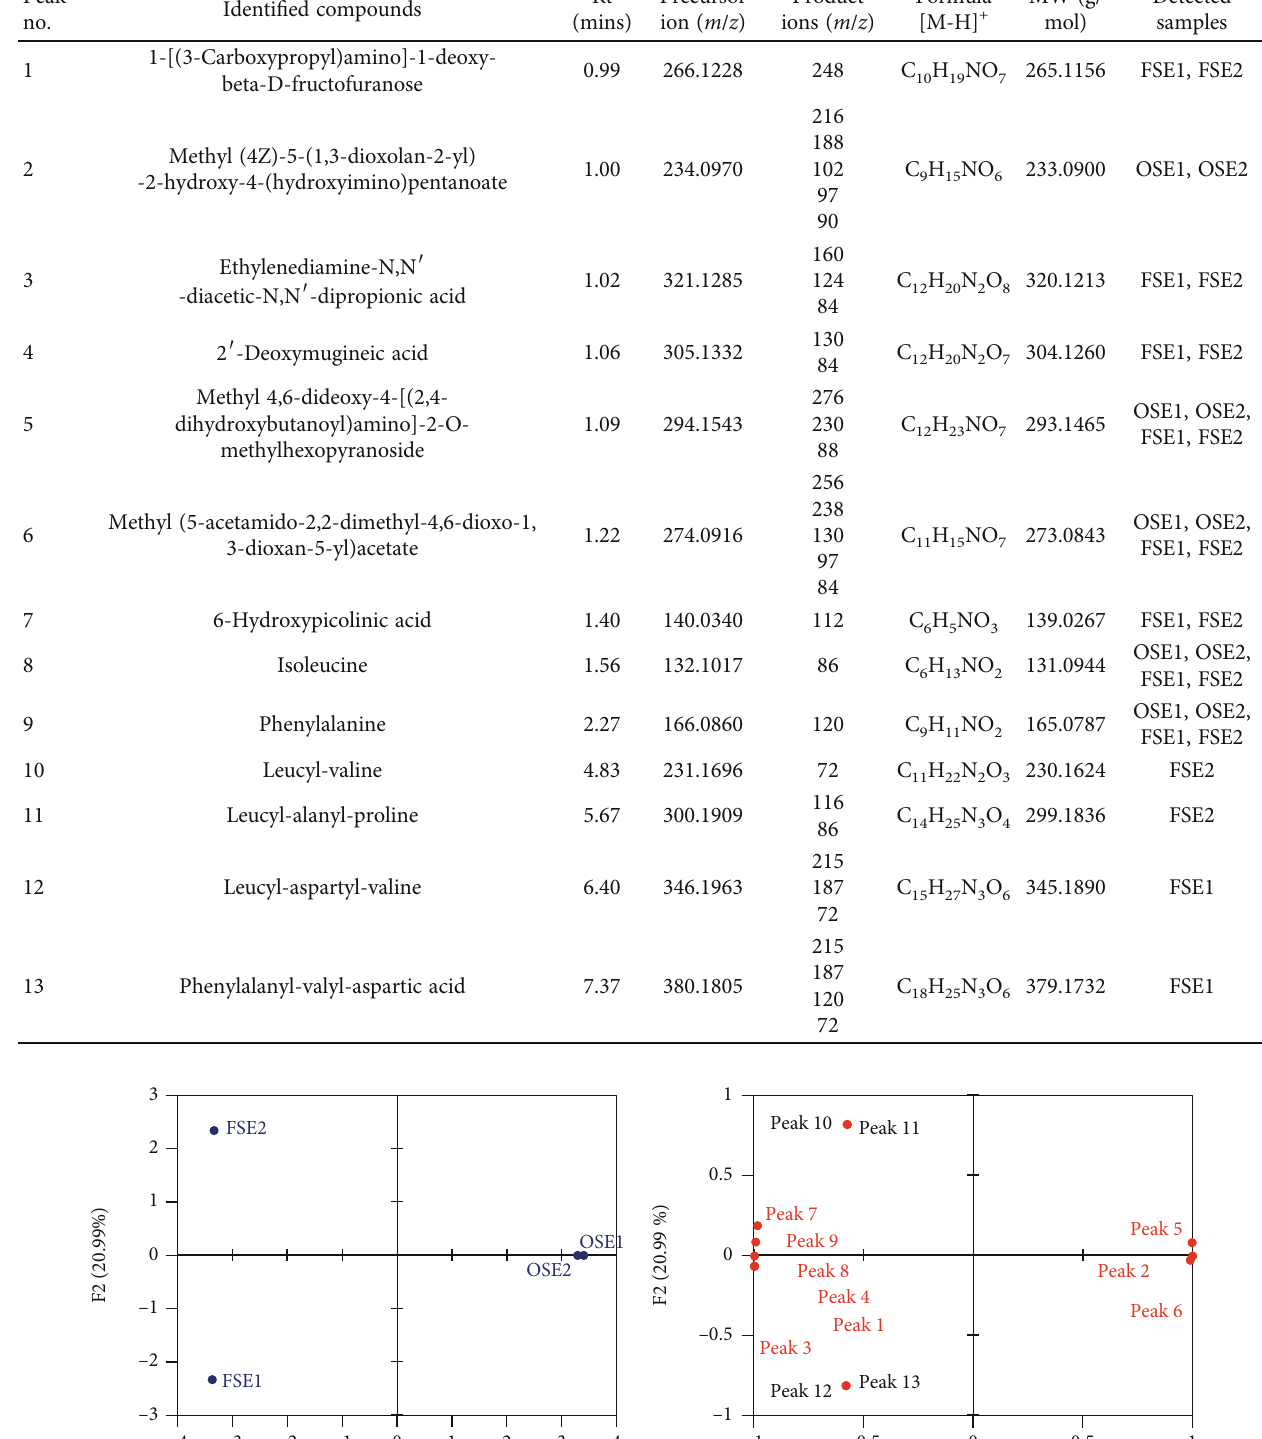
Table 5: Compounds identi fi ed in the water extract of old and fermented Pangium edule seed by LC-MS/MS analysis. Peak